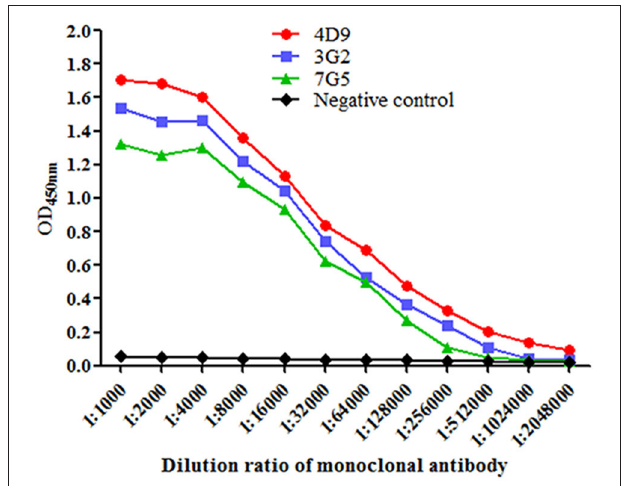
FIGURE 3 | Titers of the monoclonal antibody in mouse ascites were evaluated using indirect enzyme-linked immune sorbent assay. Data were presented as mean ± SD ( n = 3).